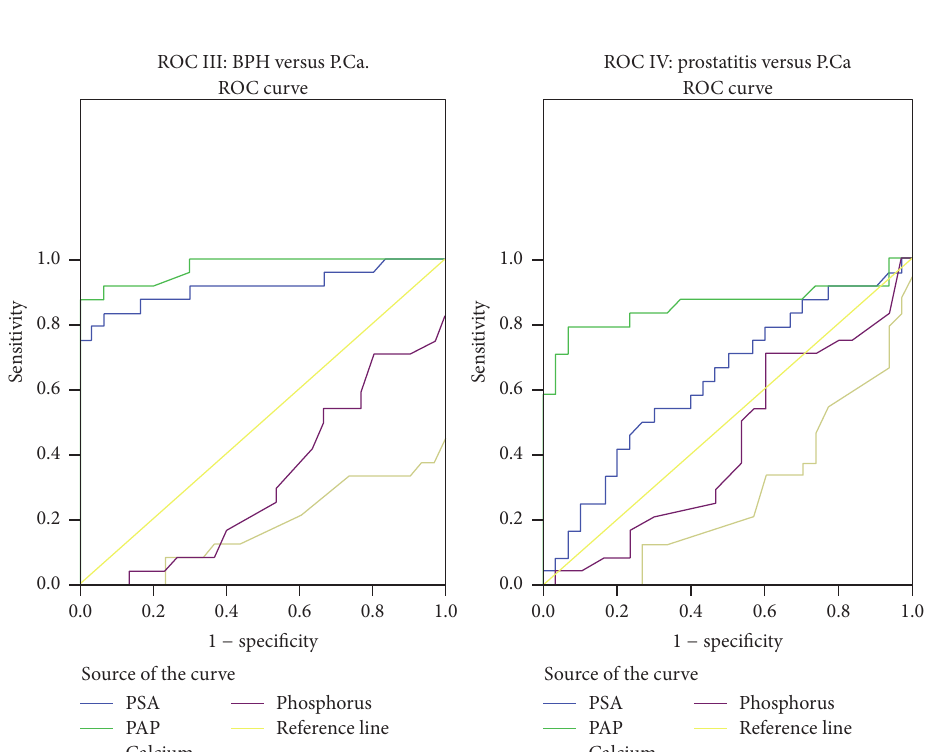
Figure 2: Receptor operative